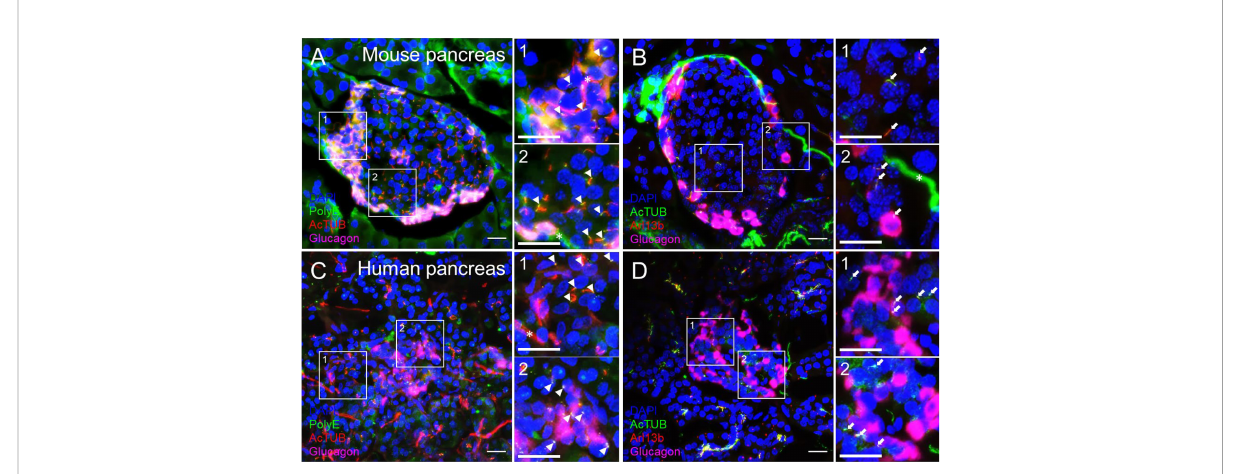
FIGURE 3 Comparison of cilia staining in mouse and human pancreas sections observed by confocal microscopy. Maximal projection of confocal images from mouse (A, B) and human (C, D) pancreata thin sections (10 µm) labeled with polyglutamylated tubulin (PolyE, green in A, C ), acetylated